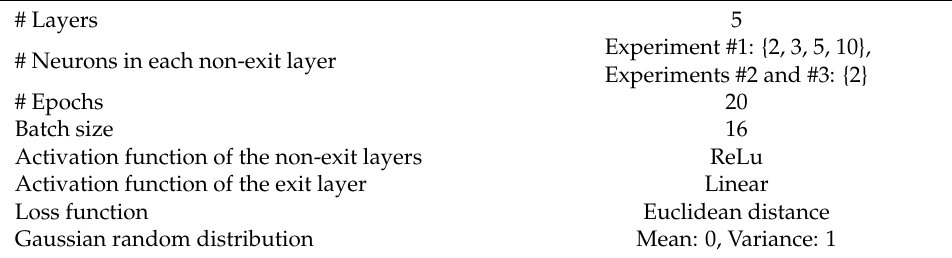
Table 4. Parameter values chosen for the proposed model